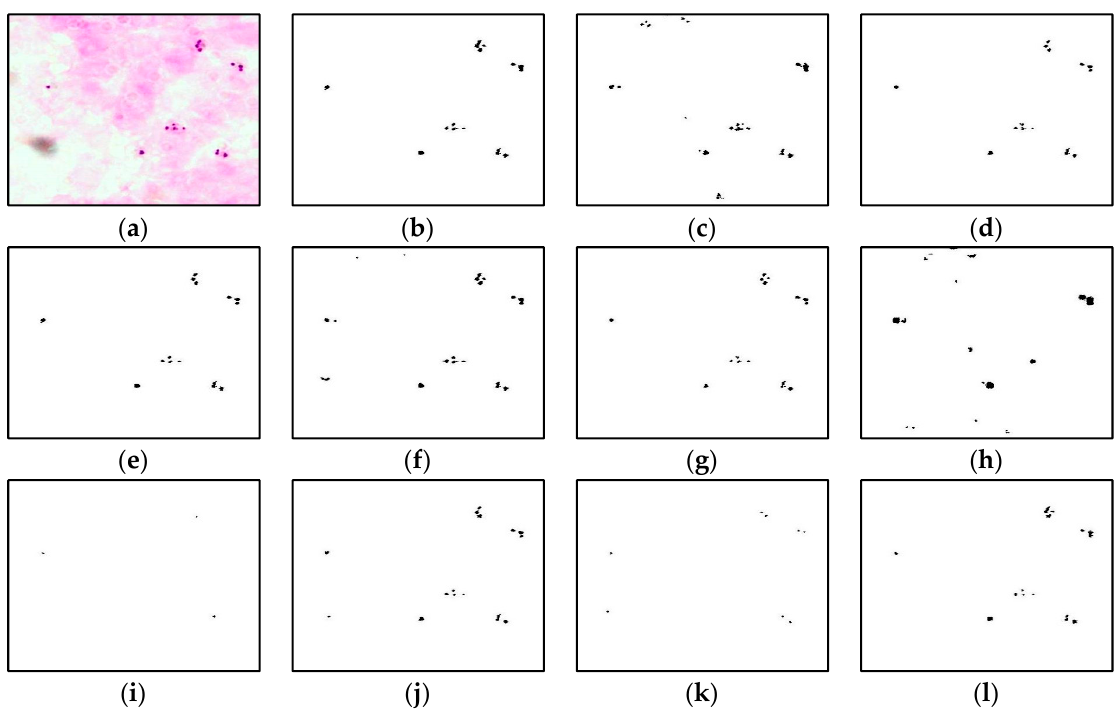
Figure 6. P. vivax of thick smear in various segmentation techniques of ( a ) original image; ( b ) adaptive thresholding; ( c ) Niblack; ( d ) Sauvola; ( e ) Phansalkar; ( f ) Bradley; ( g ) Nick; ( h ) Feng; ( i ) KM; ( j ) FCM; ( k ) FKM; ( l ) EKM.